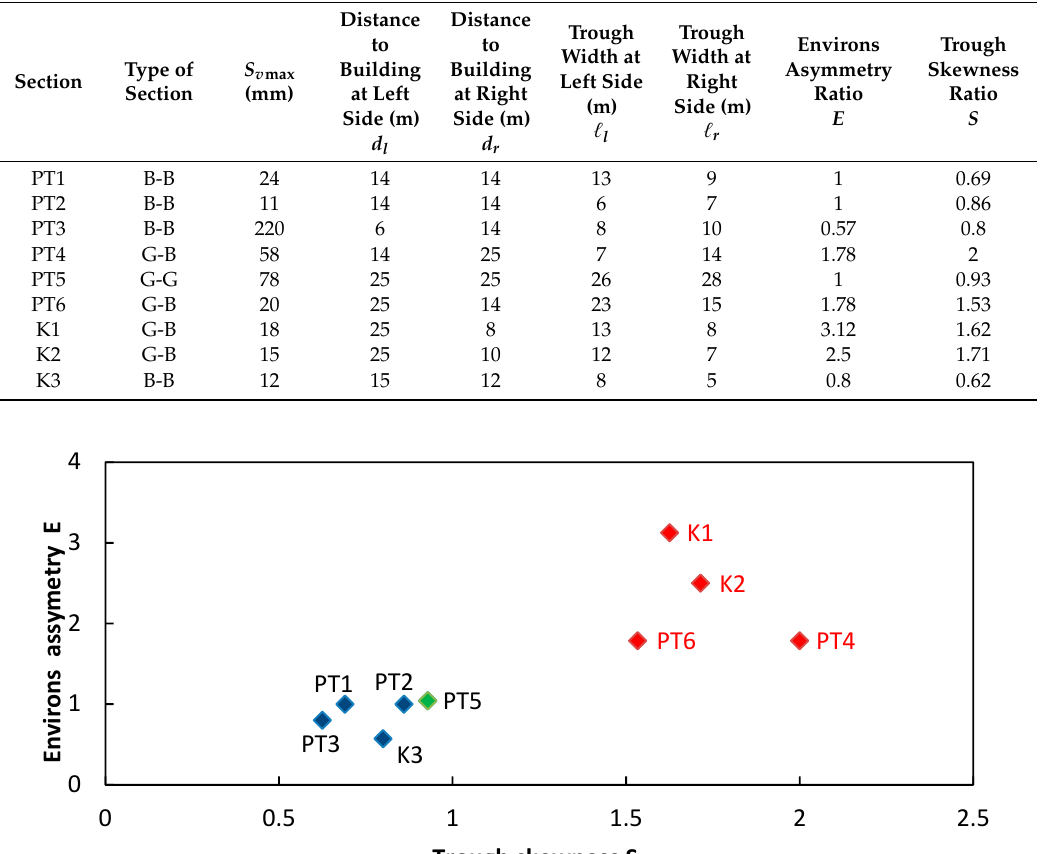
Table 2. Nine representative sections drawn along the metro tunnel axis at Panagi Tsaldari Ave., marked as PT1 to PT6, and Kifissos Ave., marked as K1 to K3 (shown in Figure 4). Distance of tunnel axis up to the closest building at left and right and the corresponding trough width are measured. Environs asymmetry ratio E and trough skewness ratio S are calculated using Equations (2) and (3). Section type (B-B, G-B, or G-G) is marked.